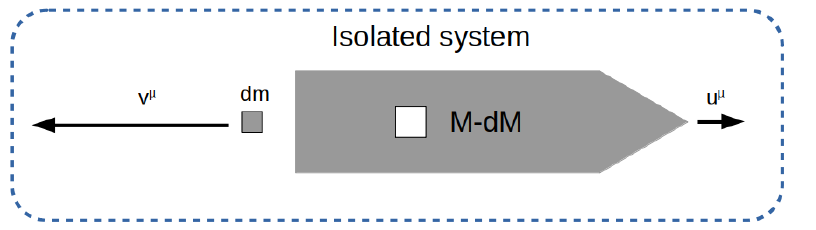
Figure 1. A schematic image of a relativistic rocket system. The relativistic propellant, of infinitesimal mass dm , is expelled to produce the rocket motion. In case of massless propellant, dmv µ is the photons